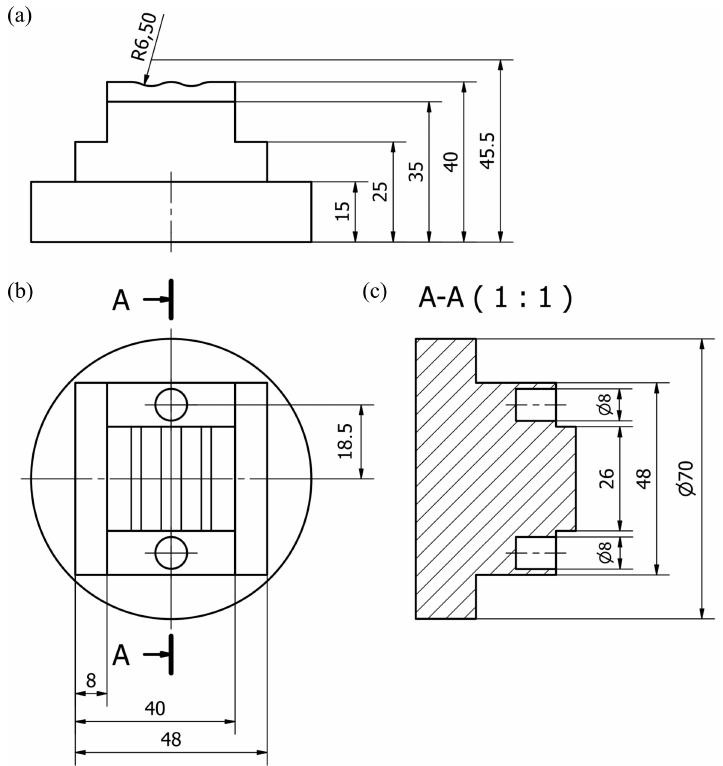
Figure 1. Dimensions of the test piece designed for experimental investigations of dimensional and shape accuracy: ( a ) front view; ( b ) top view; ( c ) cross-section A-A (all dimensions in mm).